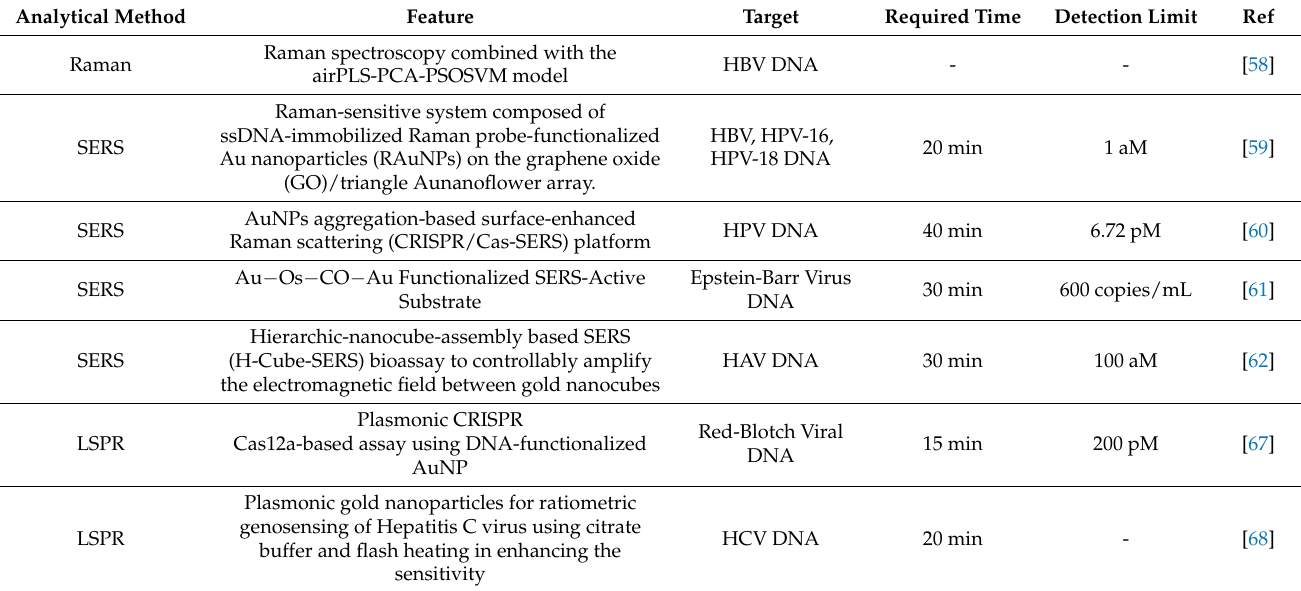
Table 2. Comparison of SERS and LSPR-based nanobiosensors for viral DNA